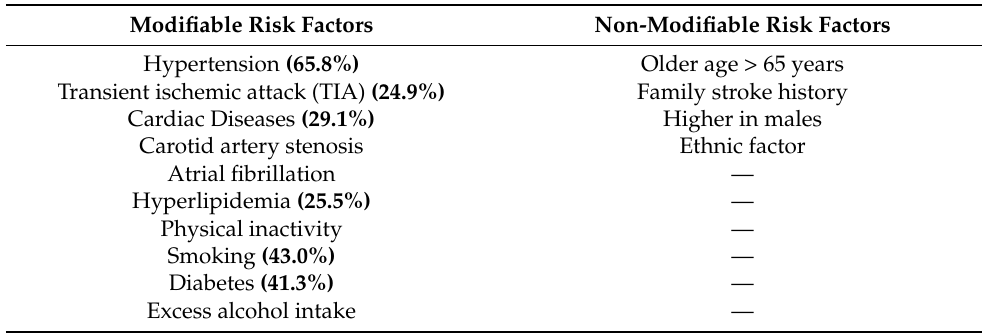
Table 2. Risk factors for stroke (modifiable and non-modifiable according to the different research studies in Pakistan, Brazil, India, and South East Asia) [11–15].